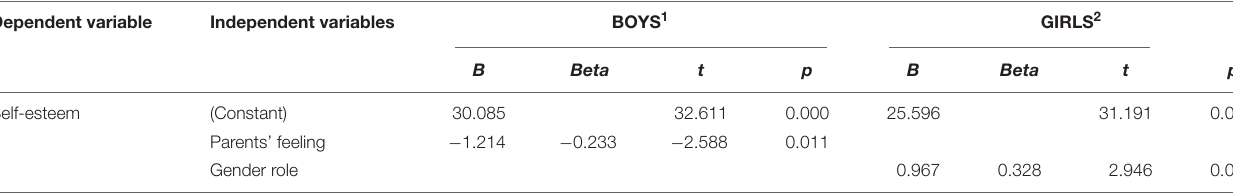
TABLE 7 | Multiple linear stepwise regression analysis of the study variables on self-esteem among boys and girls.